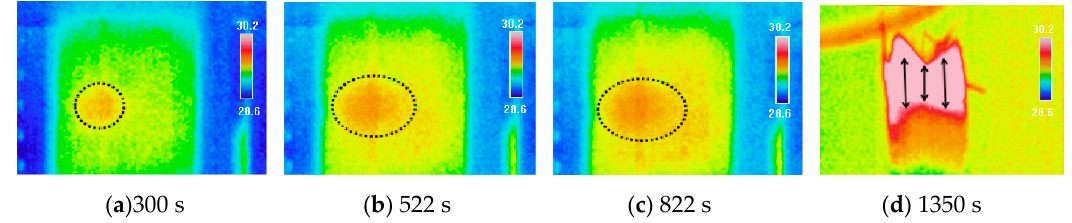
Figure 4. Thermal images of specimen A1 at different moments.